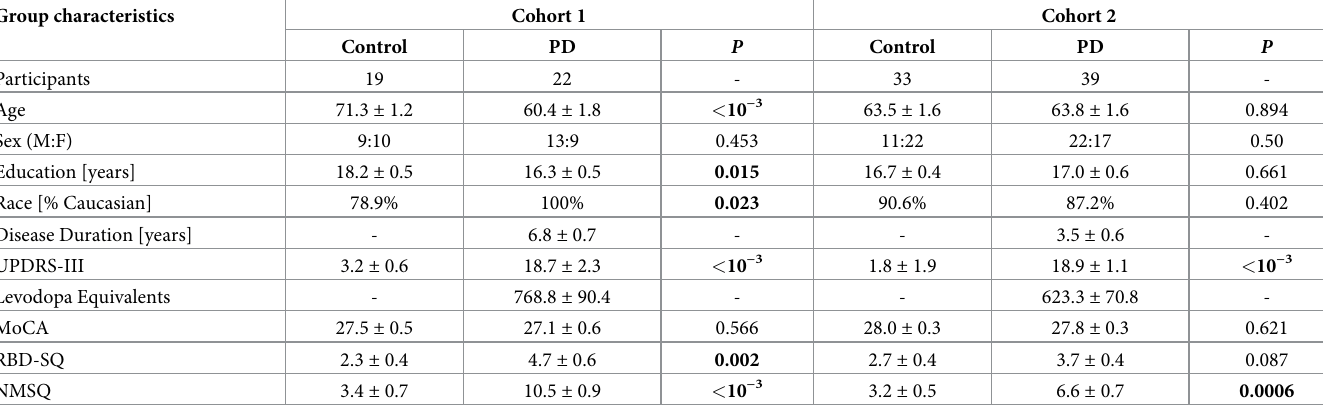
Table 1. Demographic information for the groups used in this analysis. Group